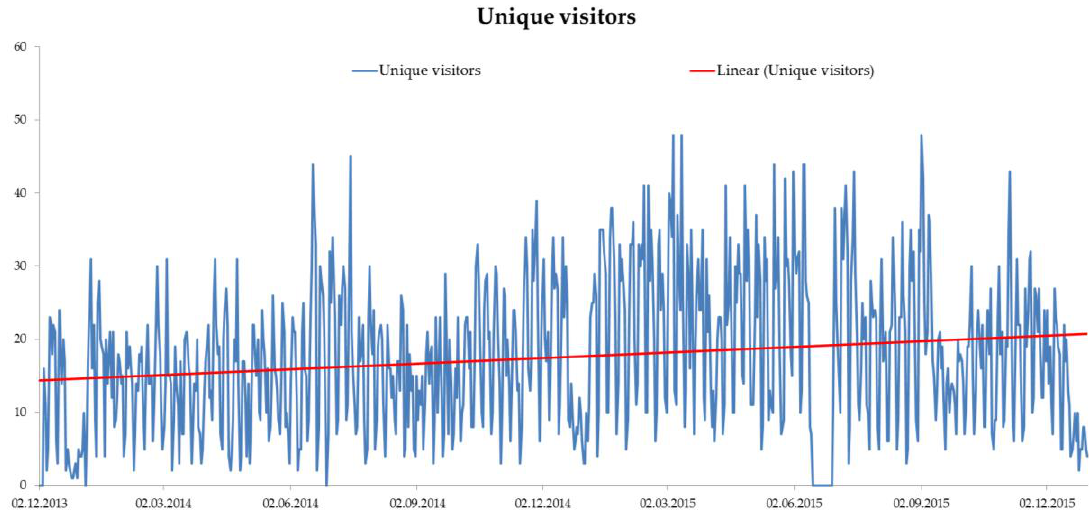
Figure 4. Usage statistic from the internal collaboration area from December 2013 until December 2015.